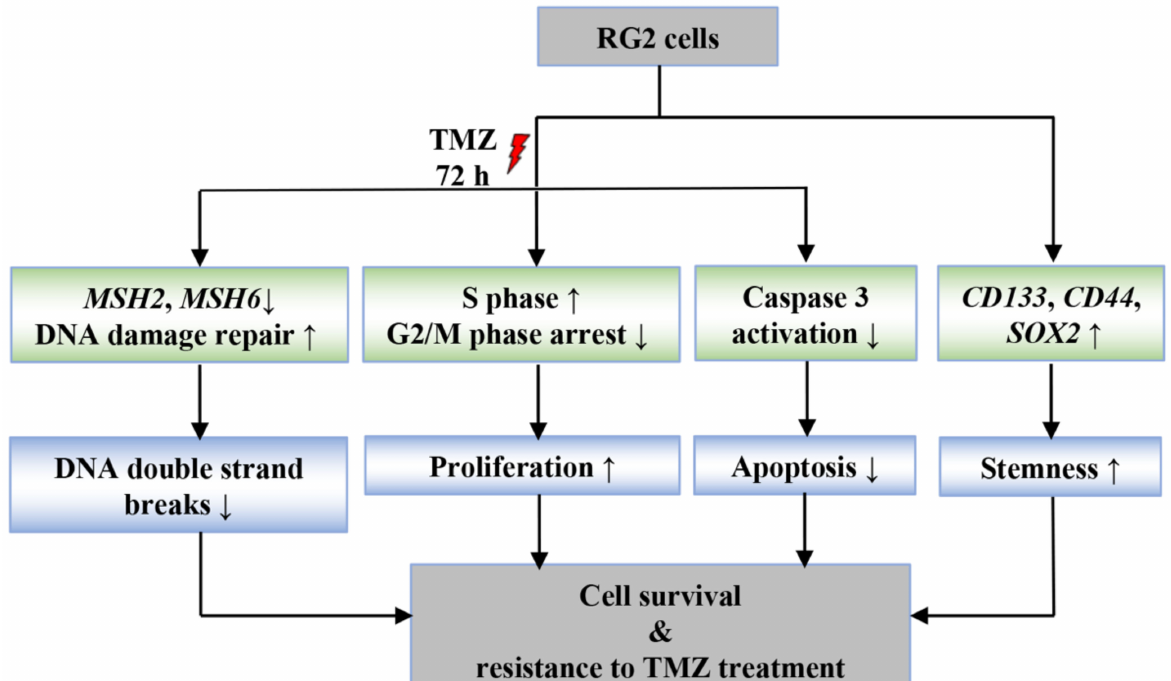
Figure 8. Characterization of the phenotype and related gene signatures in TMZ resistant GBM cells. Upon treatment with TMZ, RG2 cells showed less susceptibility and sustained growth, which resulted from reduced DSBs and downregulation of MSH2 and MSH6 , evasion from G2/M arrest and increased DNA replication (proliferation) and decreased apoptosis. Moreover, these TMZ resistant cells presented stem cell properties, as evidenced by rapid clonogenic regrowth, higher cell self- renewal capacity and upregulation of multiple stemness-related genes. All these findings highlight that our TMZ resistance model represents the key features and underlying mechanism of acquired TMZ